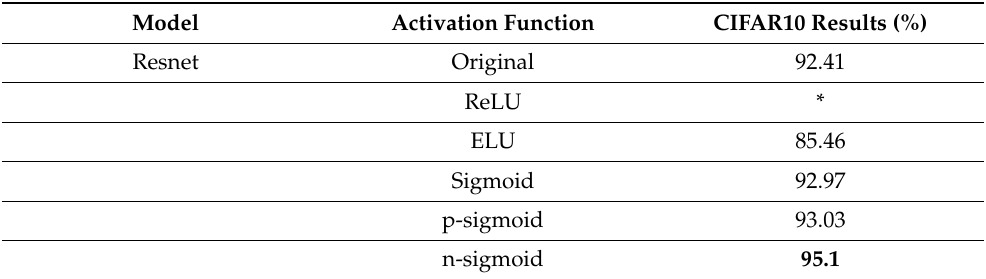
Table 2. Effects of other activation functions on the SE structure using CIFAR10.